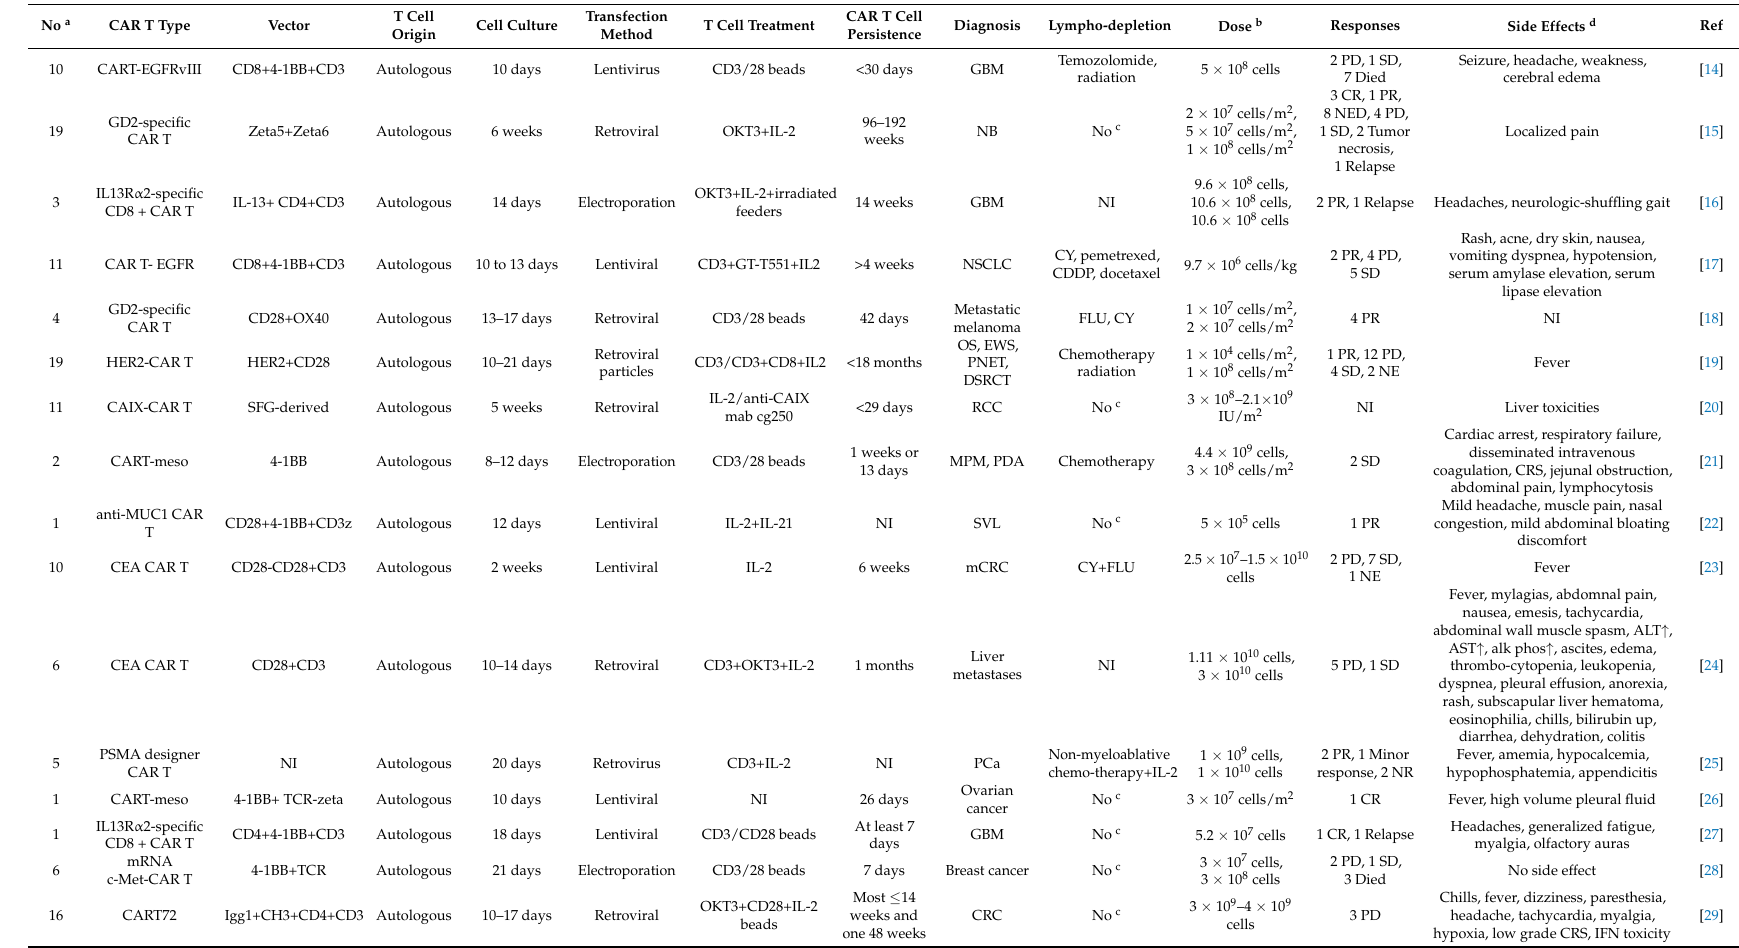
Table 2. Clinical trial